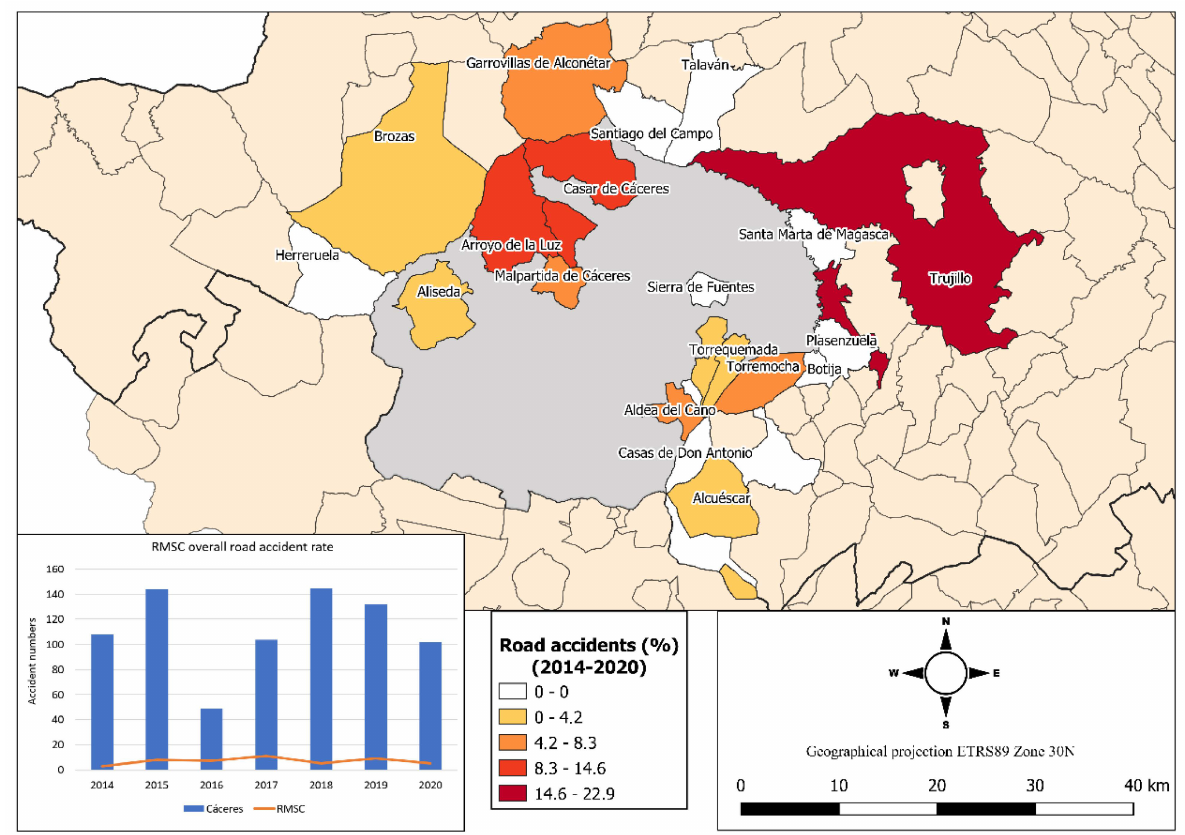
Figure 6. Road accidents in the RMSC (2014 – 2020).